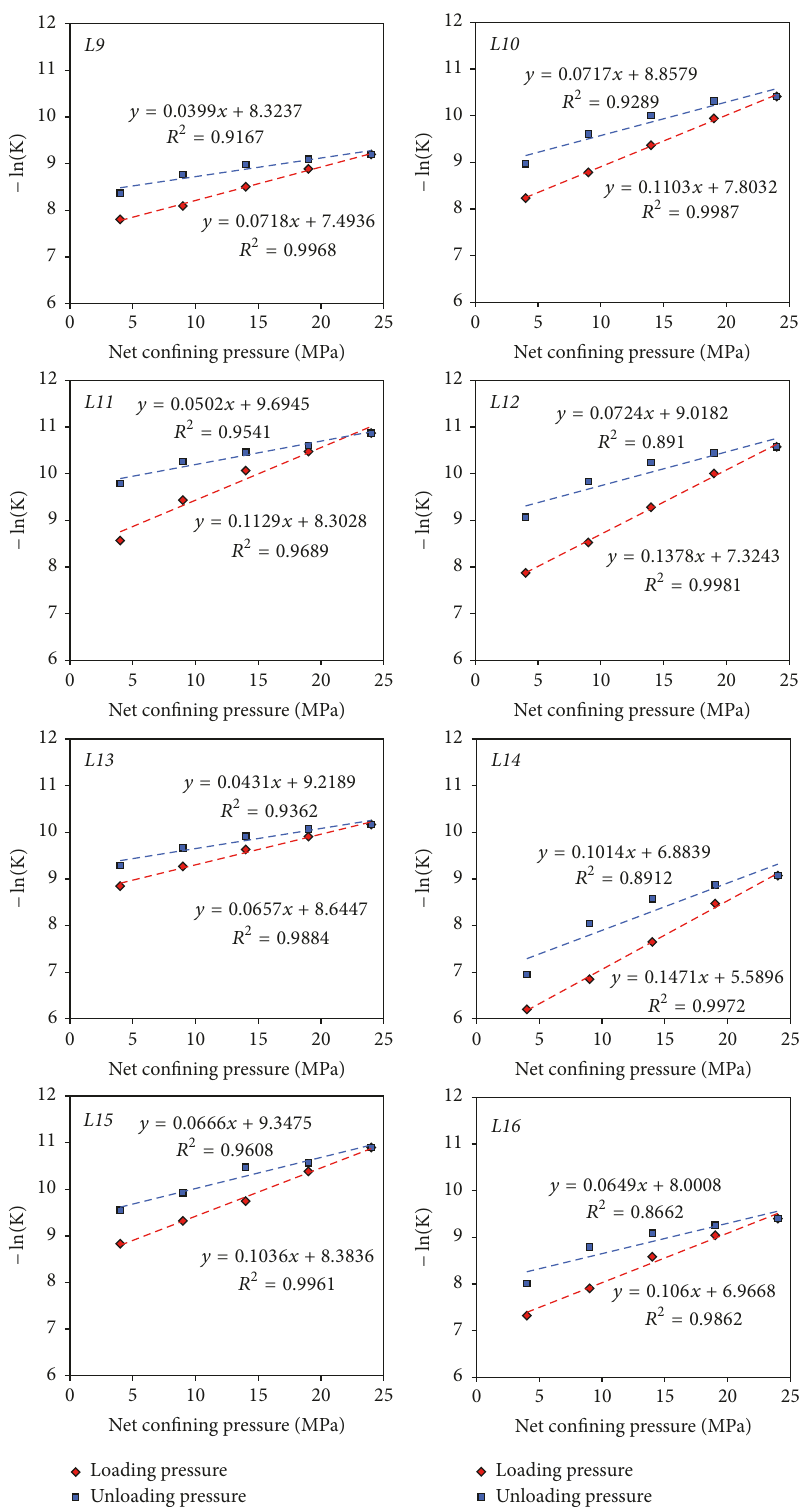
Figure 7: Negative log pulse-decay permeability as a function of net confining pressure: volcanic rocks L10–L16 for loading pressure and unloading